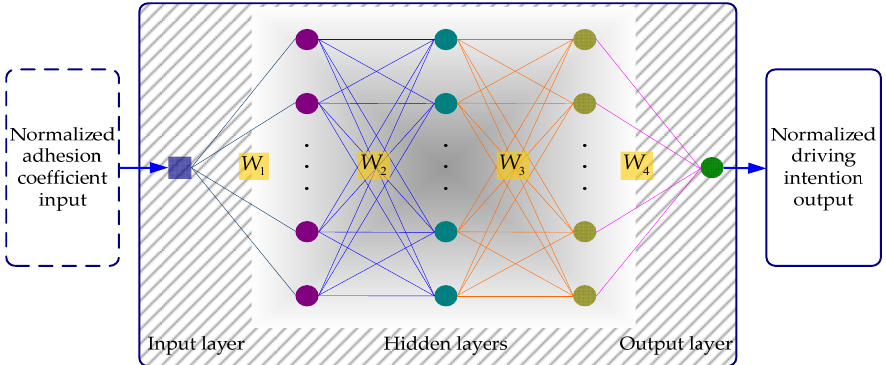
Figure 2. Deep neural network with 3 hidden layers.